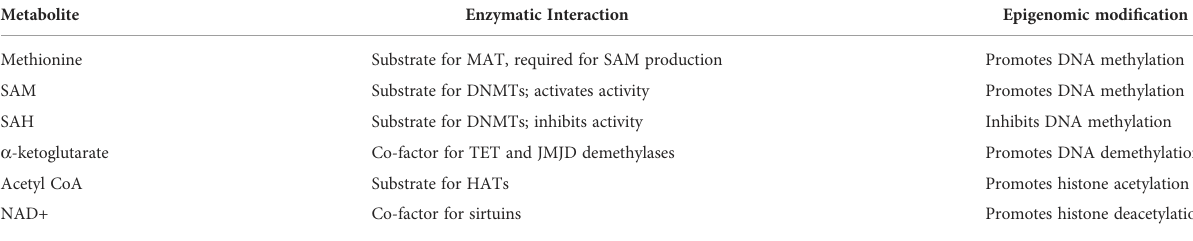
TABLE 1 Summary of selected metabolites, enzymatic interactions, and related epigenomic modi fi cation upon increase of the metabolite.